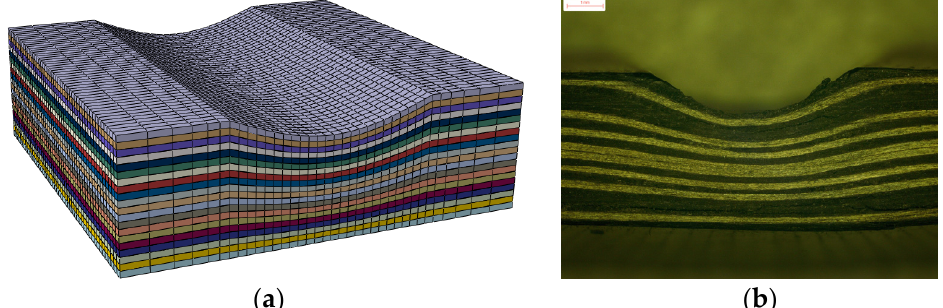
Figure 9. FE mesh and side view of specimen with − 20% fiber waviness specimen. ( a ) FE mesh of specimen ( b ) side view of the test specimen.